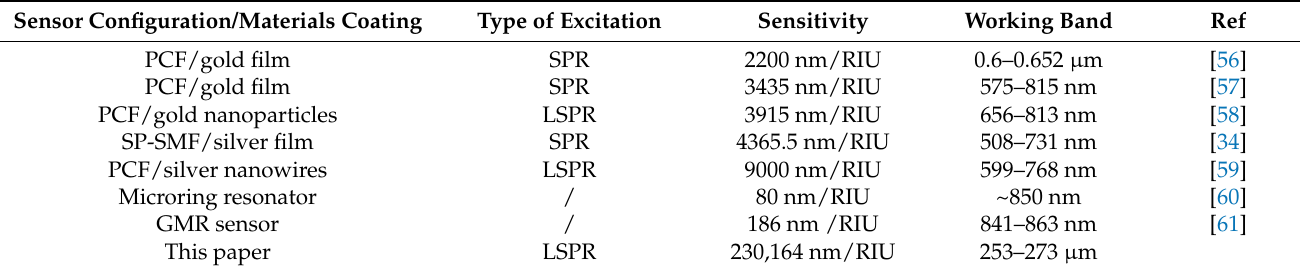
Table 1. Comparison table of the performance of the proposed biosensor and other counterparts reported in literature. Sensor Configuration/Materials